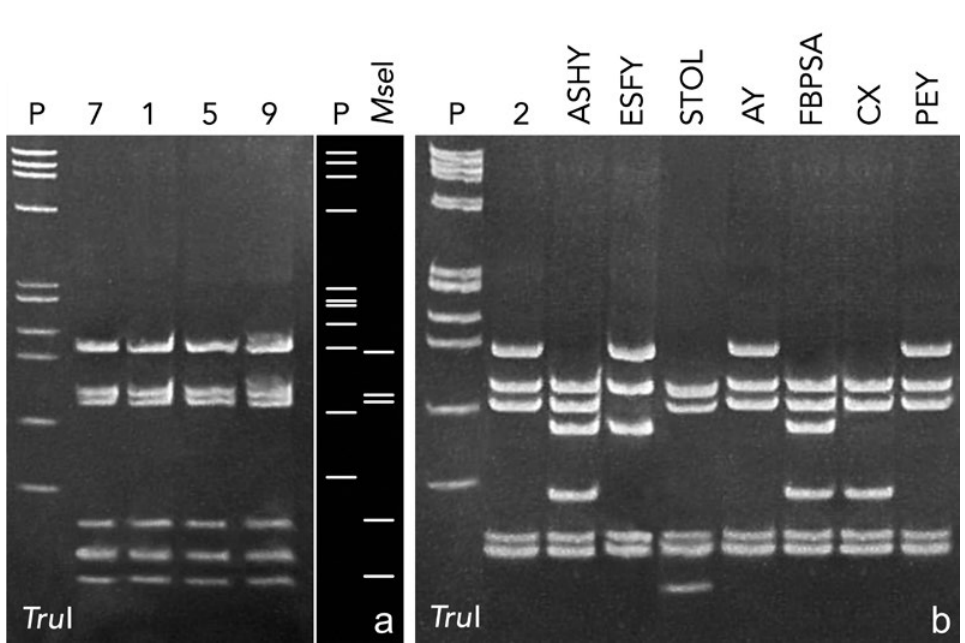
Figure 2. RFLP analyses in polyacrylamide gels of samples amplified in nested PCR with primers M1/M2 and digested with Tru I (= Tru1 I). In a),carrot samples 7, 1, 5, 9 amplified with system I and the virtual RFLP profile of the strain carrot 1 (AC KX163276) sequence cut at the same length as the M1/M2 amplicons and digested with the same enzyme ( Mse I and Tru1 I are isoschizomers). The middle bands present in the real RFLP (on the left) represent non-specific amplification (primer dimers). In b) carrot sample 2 amplified with system II and reference phytoplasma strains: ash yellows (ASHY, 16SrVII-A); European stone fruit yellows (ESFY, 16SrX-B); “stolbur” (STOL, 16SrXII-A); aster yellows (AY, 16SrI-B); faba bean phyl - lody (FBPSA, 16SrII-C); CX, peach X disease (16SrIII-A); Picris echioides yellows (PEY, 16SrIX-C). P, marker phiX174 Hae III digested with fragment sizes in base pairs from top to bottom of 1,353; 1,078; 872; 603; 310; 281; 271; 234; 194; 118 and